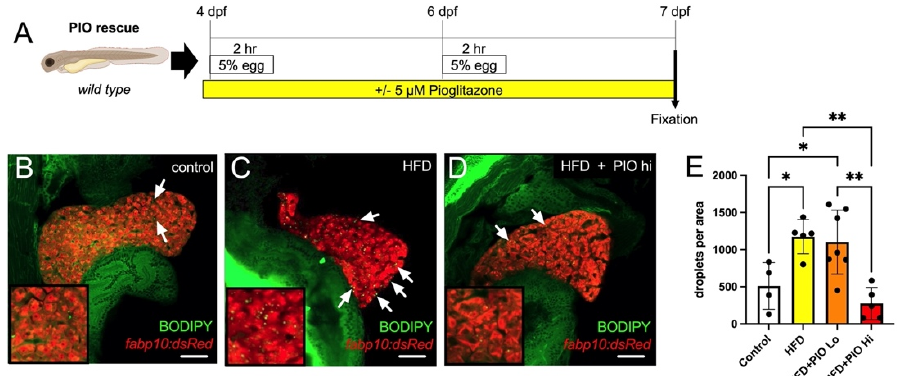
Figure 6. Pioglitazone treatment reduces lipid droplet accumulation in the liver. ( A ) Experimental scheme of PIO treatment. Larvae were immersed in PIO+ 0.1% DMSO for 1 h prior to the first HFD treatment and remained in PIO throughout. ( B – D ) Representative optical slices of BODIPY-stained 2CLIP zebrafish liver depicting ( B ) untreated controls, ( C ) HFD-fed larvae, and ( D ) HFD-fed + PIO hi (5 µM) treated larvae; hepatocytes are labeled in red via expression of the transgene fabp10:dsRed and examples of green-labeled lipid droplets are indicated by arrows. ( E ) Quantification of lipid droplets in hepatocytes area as executed with FIJI software. Statistical analysis was by one-way ANOVA; * p < 0.05, ** p < 0.01. Scale bar = 50 µm.